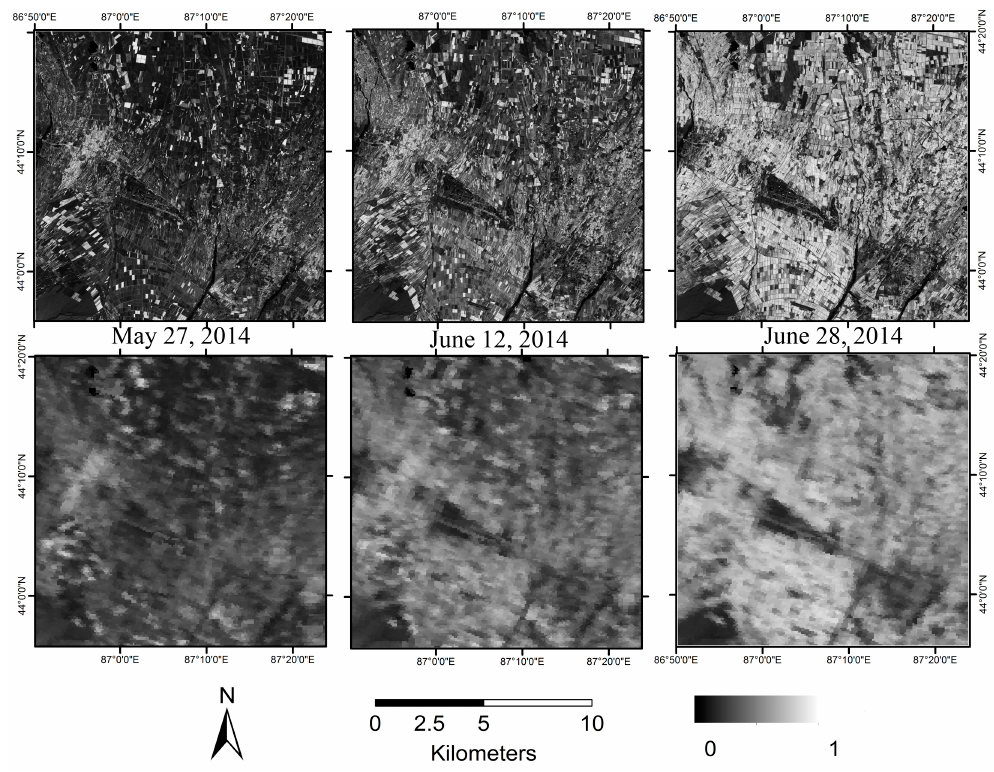
Figure 5. Landsat ( upper row )1 and MODIS ( lower row ) NDVI images from three dates in 2014 over a cropland area in Xinjiang, China.